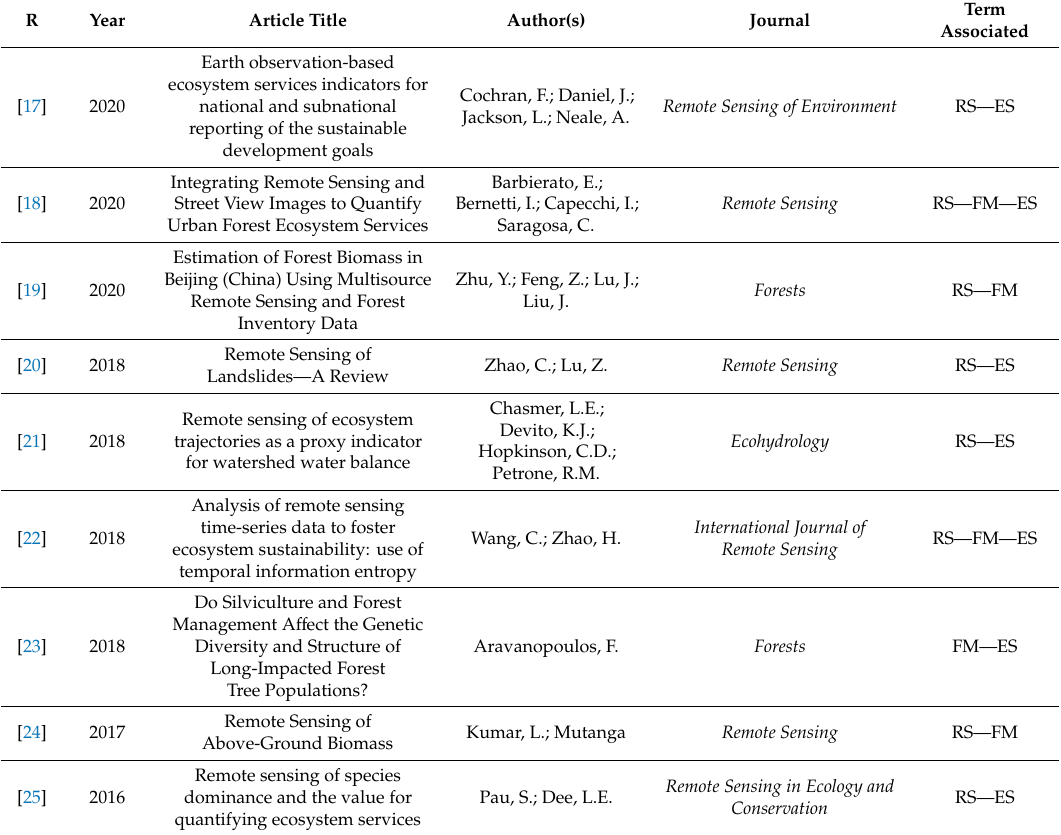
Table 1. Main literature reviewed on the research